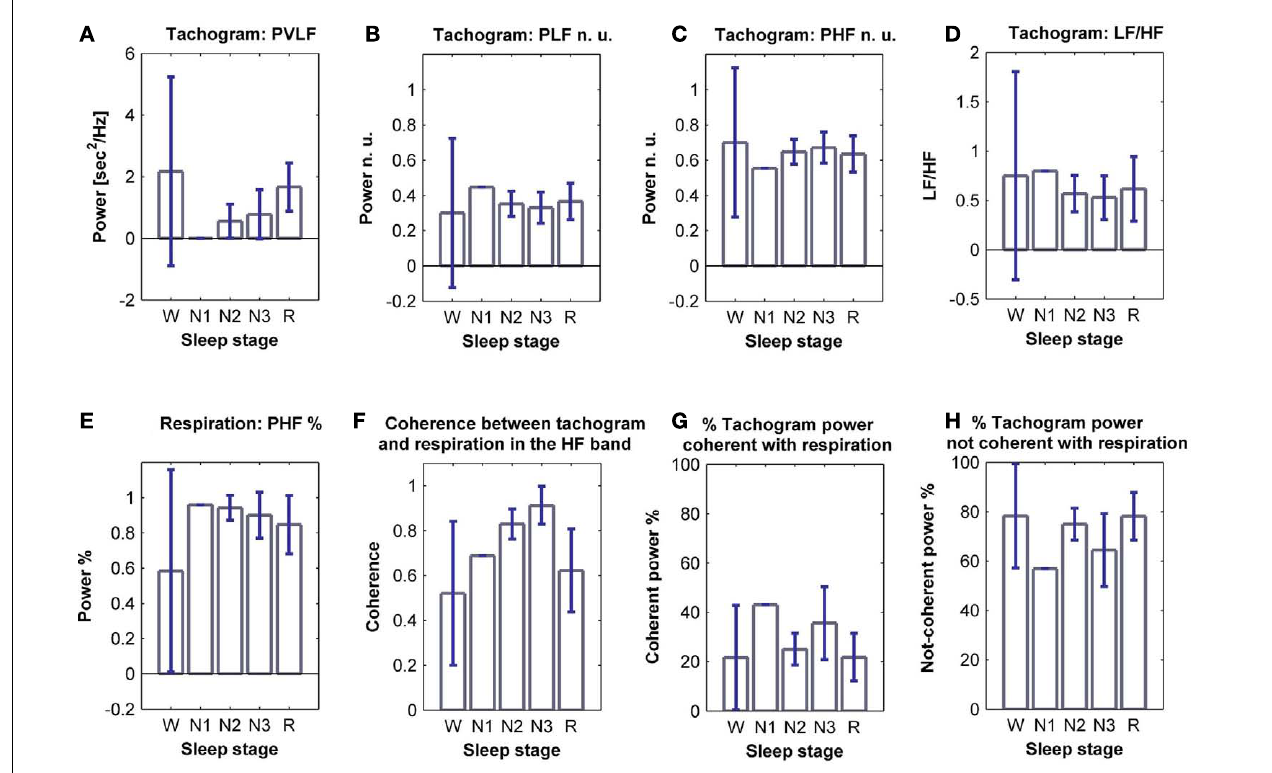
coherence between the tachogram and the respirogram in the HF band, tachogram power % (G) coherent and (H) not-coherent with the respirogram, calculated on the same subject for wakefulness and the different sleep stages, for the whole night. SD values are indicated in